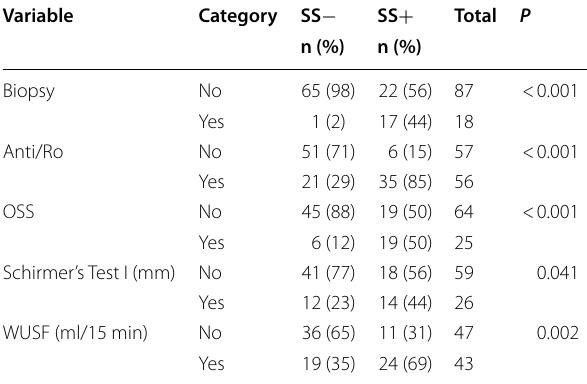
) and without (SS ) Sjögren’s syndrome + −